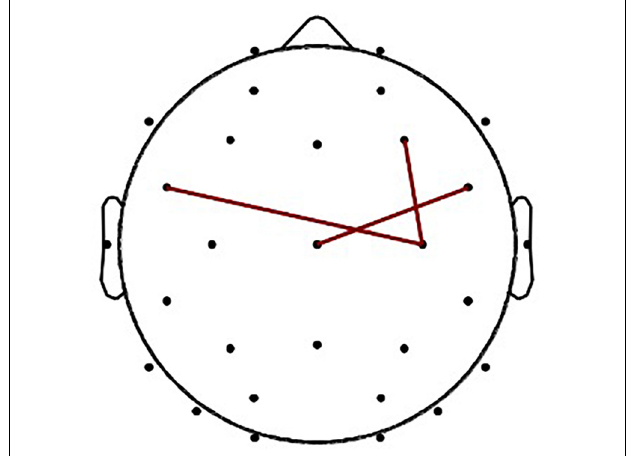
FIGURE 3 | The wPLI in Experiment Group (interaction: F4–C4, FC5–C4, FC6–Cz).